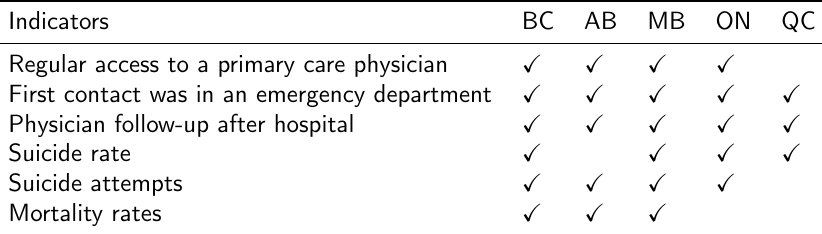
Table 1: Provincial data available for each